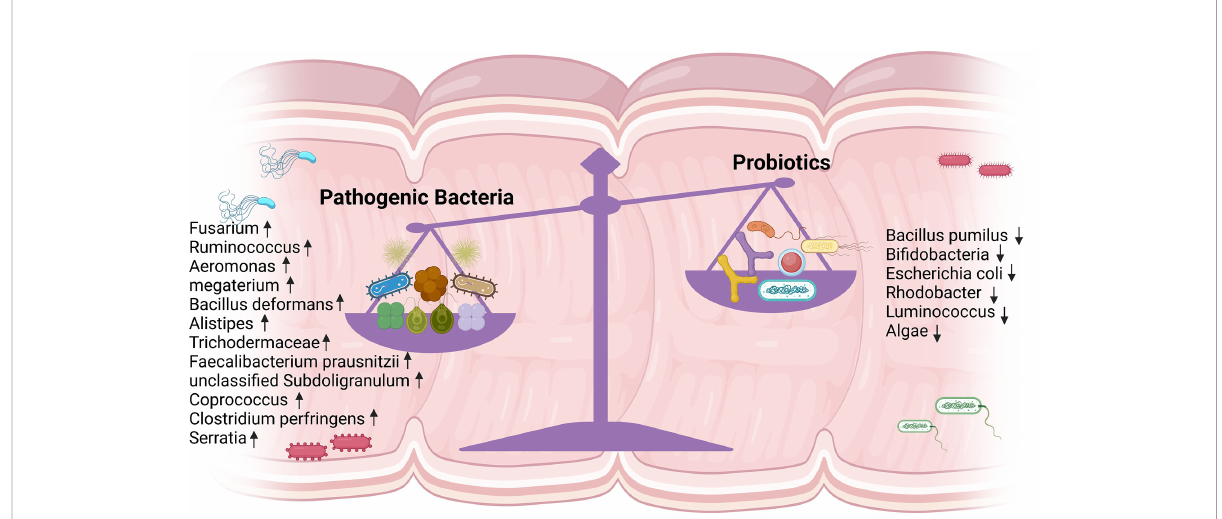
FIGURE 2 Altered intestinal fl ora in INRs. A noticeable increase in pathogenic bacteria and a signi fi cant decrease in probiotics were detected. INRs, immune